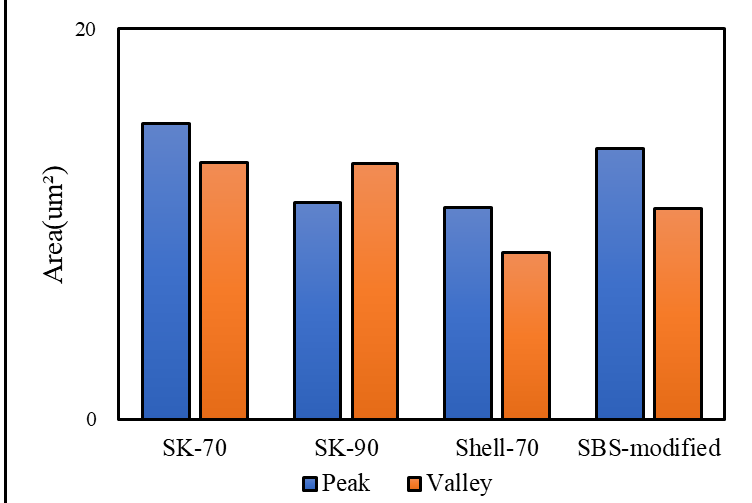
Figure 7. The area of bee-like structure in original asphalt.